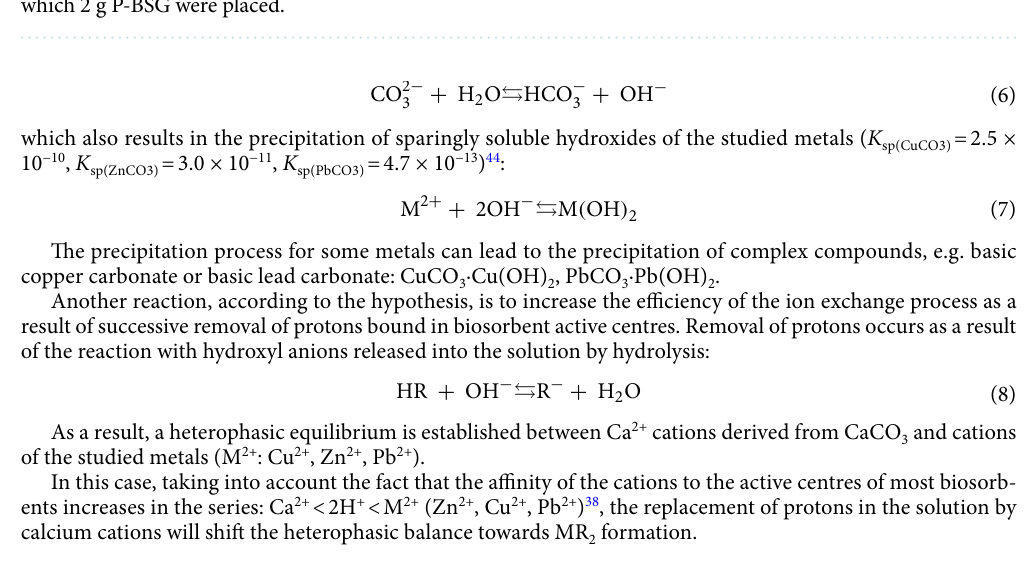
Figure 9. Effect of added BS on changes of OH − ion concentration during titration of 200 mL deionised water with NaOH standard solution (0.001 mol L −1 ); determinations: ( a ) changes in calculated OH − ion concentration values, ( b ) changes in OH − ion concentration during titration of water used for experiments (pH0 = 5.17), ( c ) range of OH − ion concentration changes in titrated solutions in which 2 g of crushed spelt or buckwheat grains were placed, ( d ) range of OH − ion concentration changes in titrated solutions in which 2 g of bran: spelt, buckwheat, rice, wheat or BSG were placed, ( e ) range of OH − ion concentration changes in titrated solutions in which 2 g P-BSG were